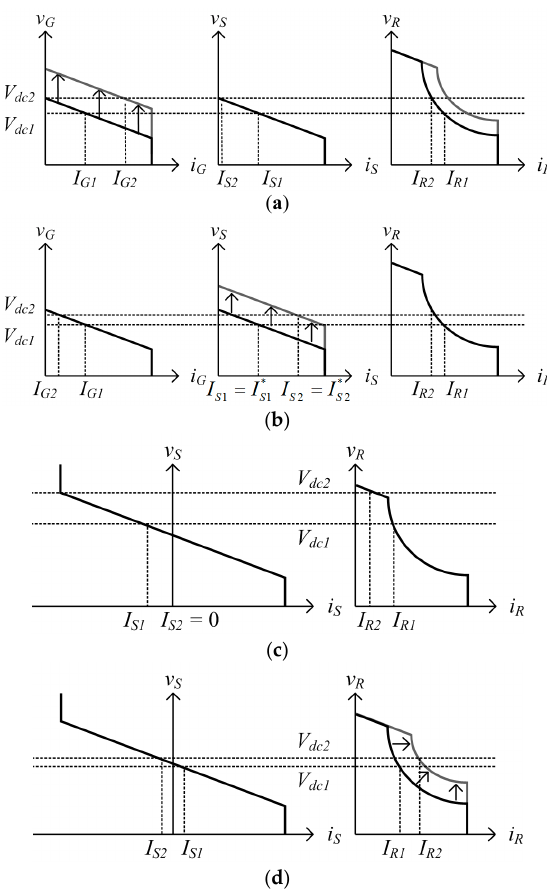
Figure 3. V – I curves of the converters for various operation examples. ( a ) Voltage reference change of GC after relevant transition; ( b ) voltage reference change of SC by energy management system (EMS); ( c ) failure of GC; and ( d ) change of photovoltaic (PV) generating power.